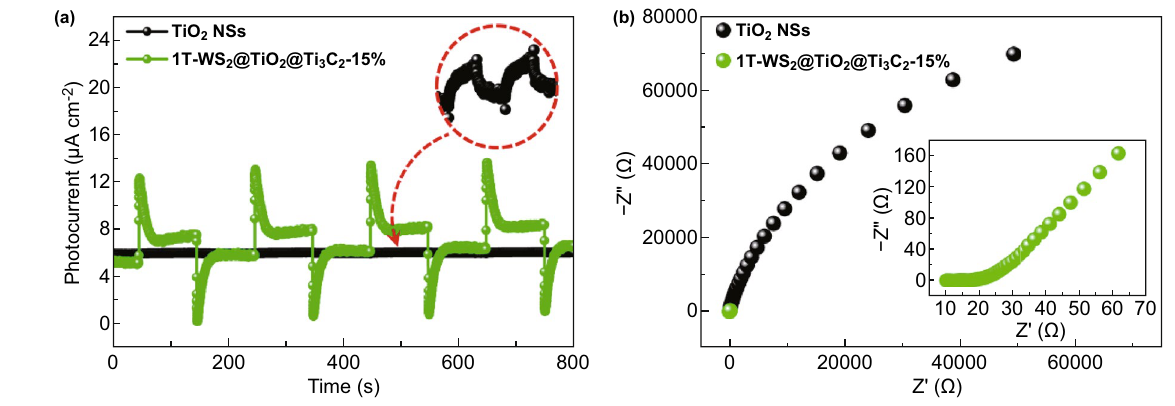
Fig. 8 a Transient photocurrent responses and b EIS of TiO 2 NSs and 1T-WS 2 @TiO 2 @Ti 3 C 2 composites (15 wt% WS 2 )